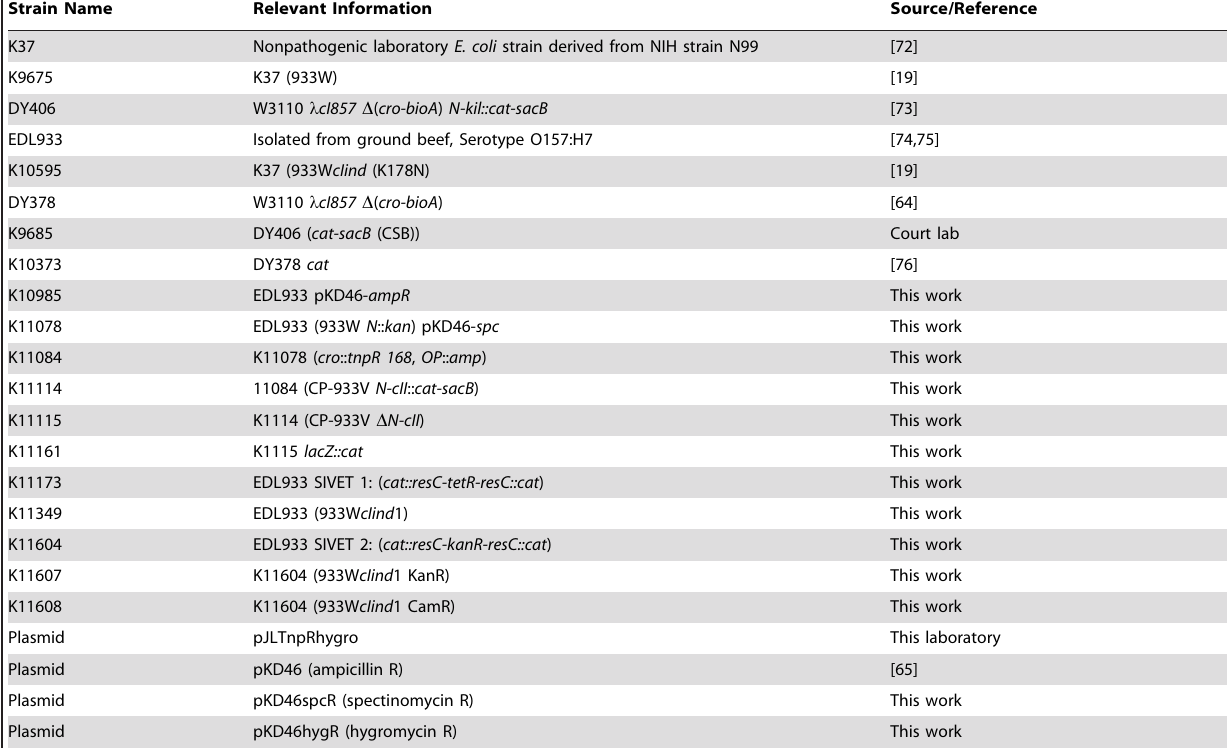
Table 1. Strain and plasmid list.